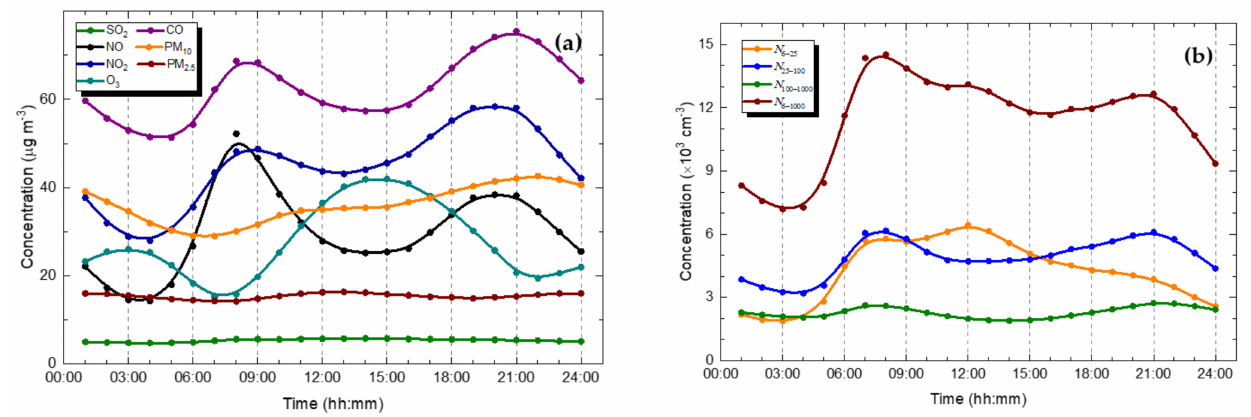
Figure 2. Mean diurnal variation in concentrations of SO 2 , NO, NO 2 , O 3 , CO, PM 10 , and PM 2.5 masses ( a ) and particle number concentrations in 6–25, 25–100, 100–1000, and 6–1000 nm size ranges ( b ) for the city center for 8 years. The concentration of CO was divided by 10. The smoothed curves serve to guide the